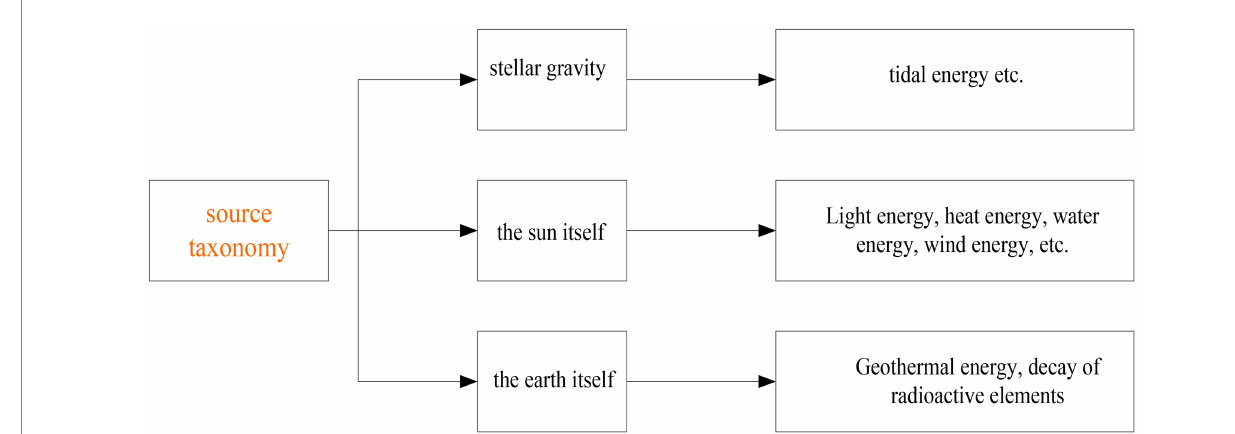
FIGURE 1 Classification of energy sources.